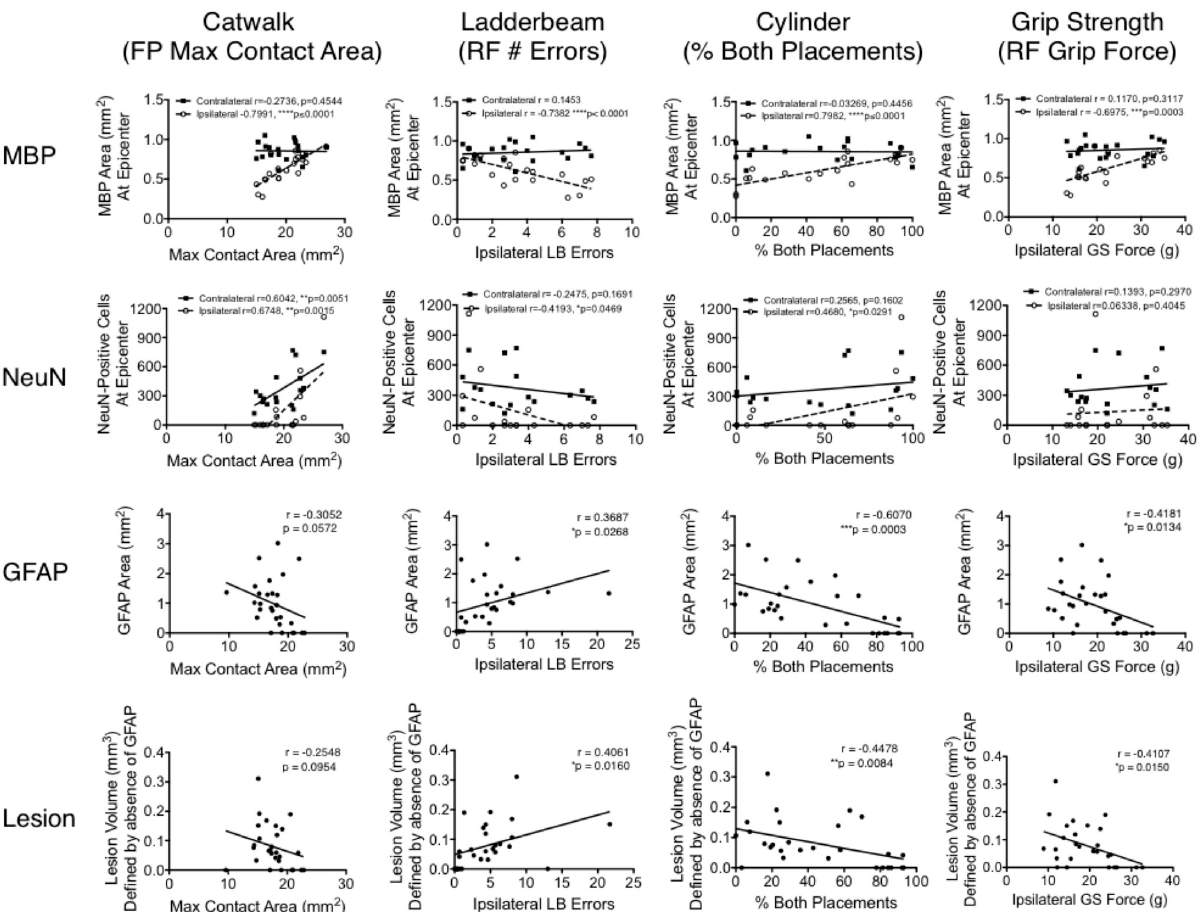
Fig 4. Correlation between behavioral outcomes and histological parameters following a unilateral cervical contusion injury in mice (C57BL/6) at 8 weeks post-SCI. Correlation results between MBP area, NeuN cell counts, GFAP area as well as lesion volume and behavioral tasks were evaluated with parametric Pearson analysis (r and p-values reported). These values used for correlative assessment are pooled from assessment of neuroanatomical integrity at 8-weeks post-SCI (Fig 3) and the corresponding functional outcomes at 8-weeks post-SCI (Fig 2).